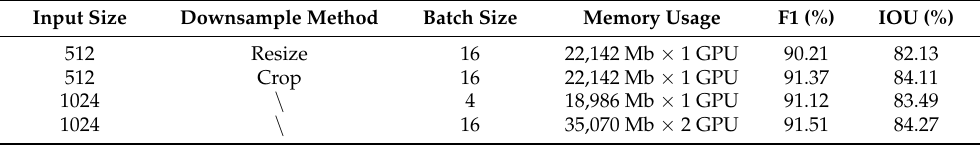
Table A1. Metrics of MFNet-Conv model on LEVIR-CD with different input size and batch